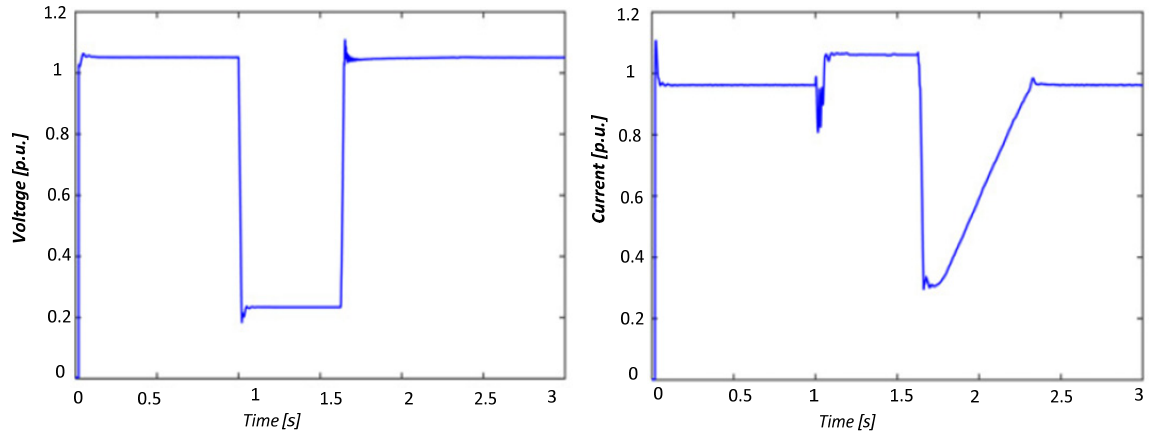
Figure 14. Voltage and current behavior under a three-phase short-circuit.